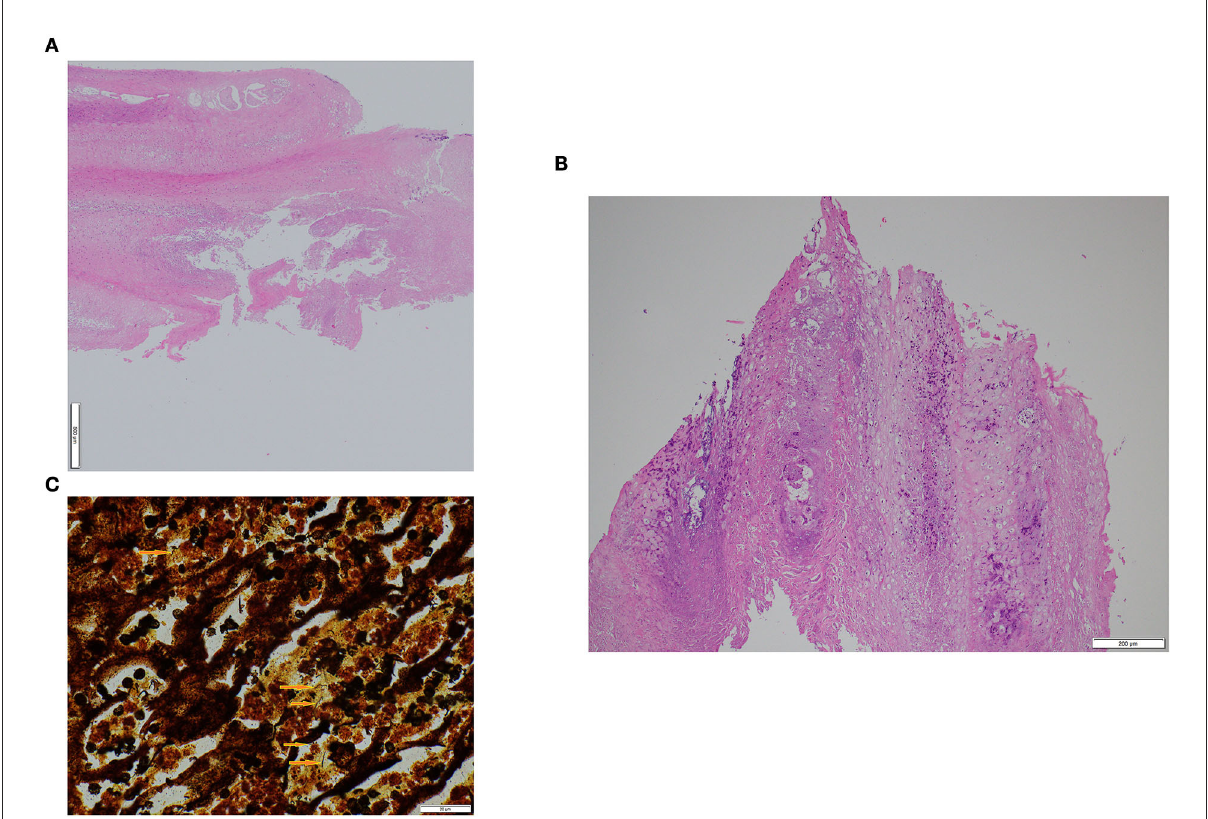
FIGURE2 Histological appearance of interdigital hyperplasia associated with contagious ovine digital dermatitis treponemes in a ram (A) and a ewe (B) . Warthin-Starry staining showing helicoidal-shaped bacteria (arrows) compatible with spirochetes in the ram (C) . Magnification (100 × ).